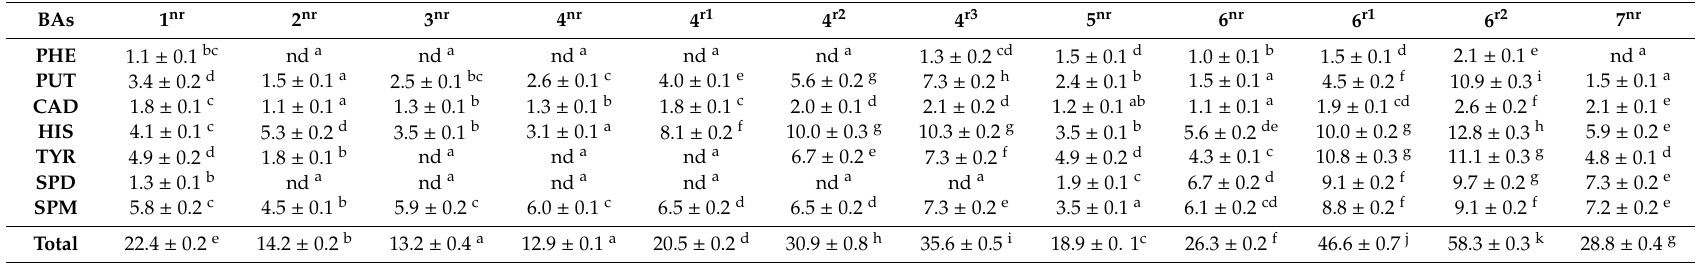
Table 4. Biogenic amines (BAs) in fermented and roasted cocoa beans samples. Results in mg kg − 1 vegetal